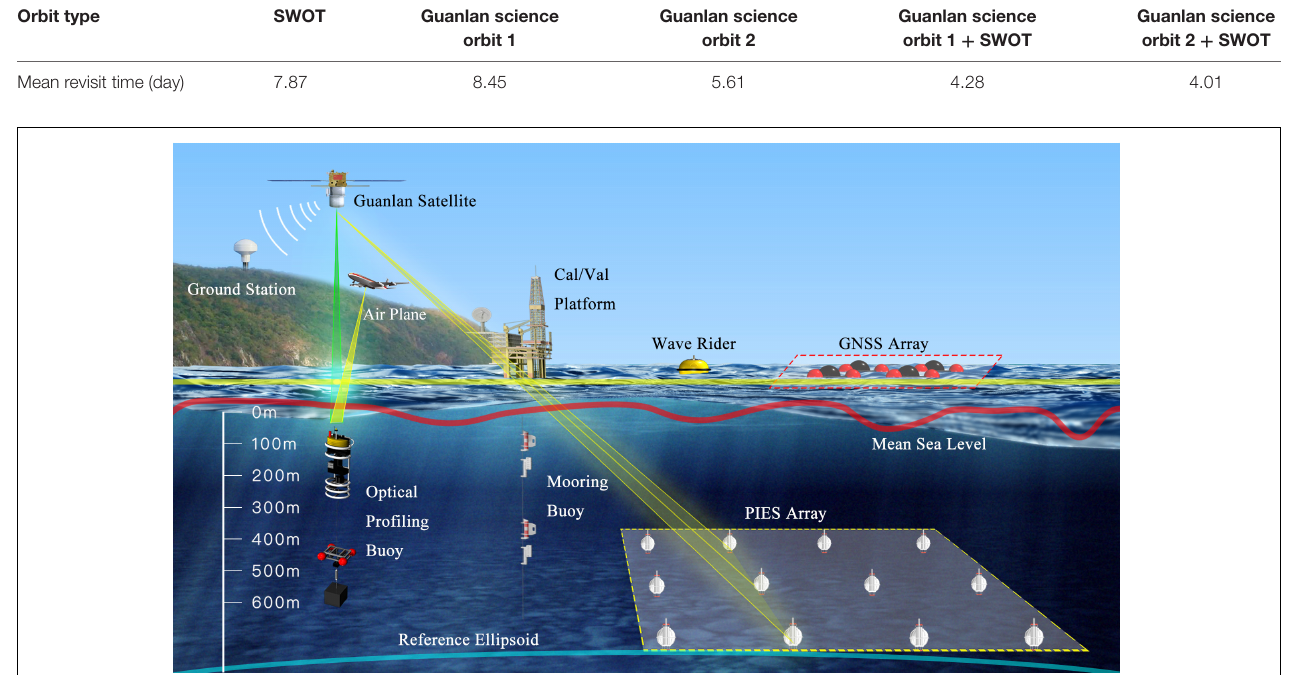
TABLE 3 | Mean revisit time for Guanlan and SWOT.